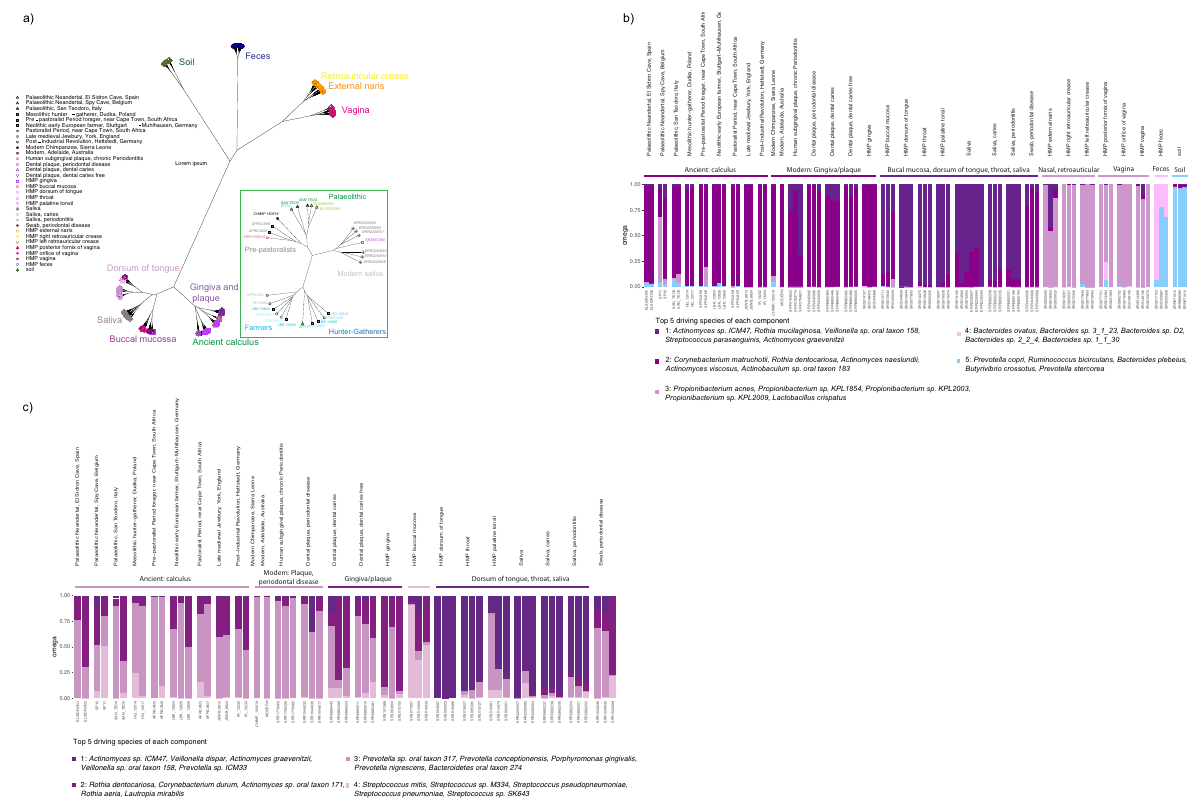
Fig. 4 Clustering of ancient microbiomes. a Dendrogram showing clustering of microbial composition data using centred log-ratio (CLR) transformed counts and Aitchinson distance, using species set ‘ all ’ . Green inset shows structure among ancient samples only. b Bar plots showing Grade of Membership (GoM) for ancient calculus and selected modern samples for k = 5 components, using species set ‘ all ’ (Supplementary Data 23). c GoM of oral samples for k = 4 components, using the species set ‘ oral ’ (Supplementary Data